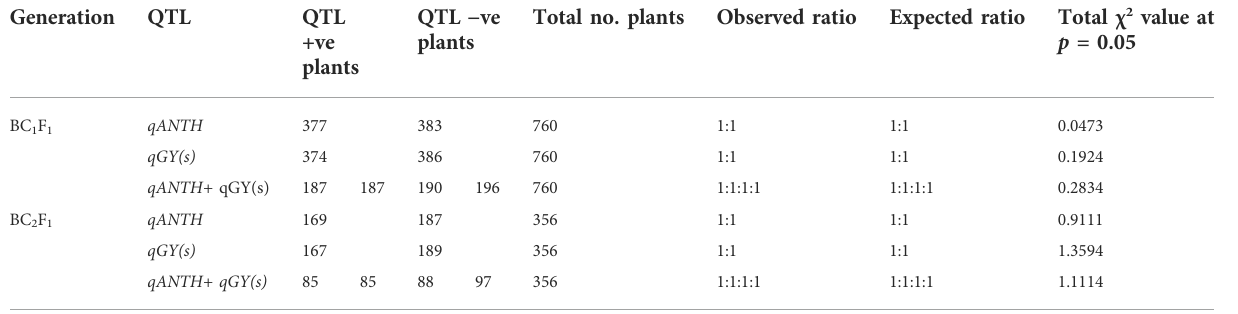
TABLE 3 Chi-square ( χ 2 ) test for QTL segregation in backcross generations.